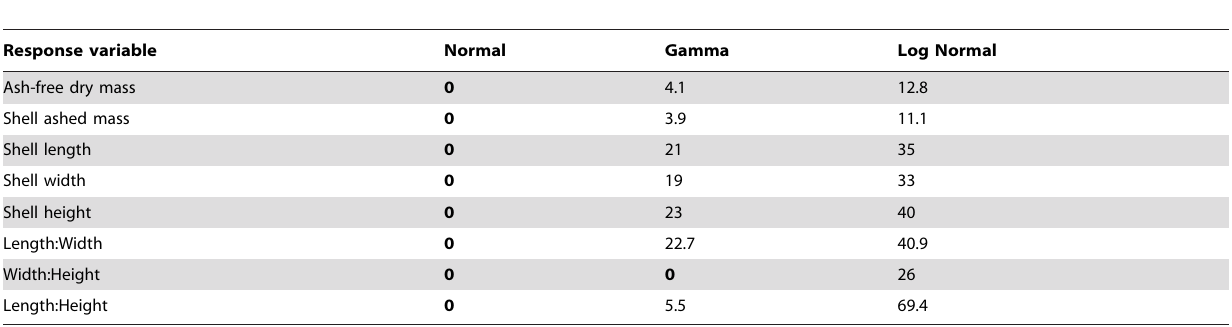
Table 2. Relative fit ( D DIC) of normal, gamma and log normal distributions to the mussel characteristics in artificially reared Lampsilis siliquoidea